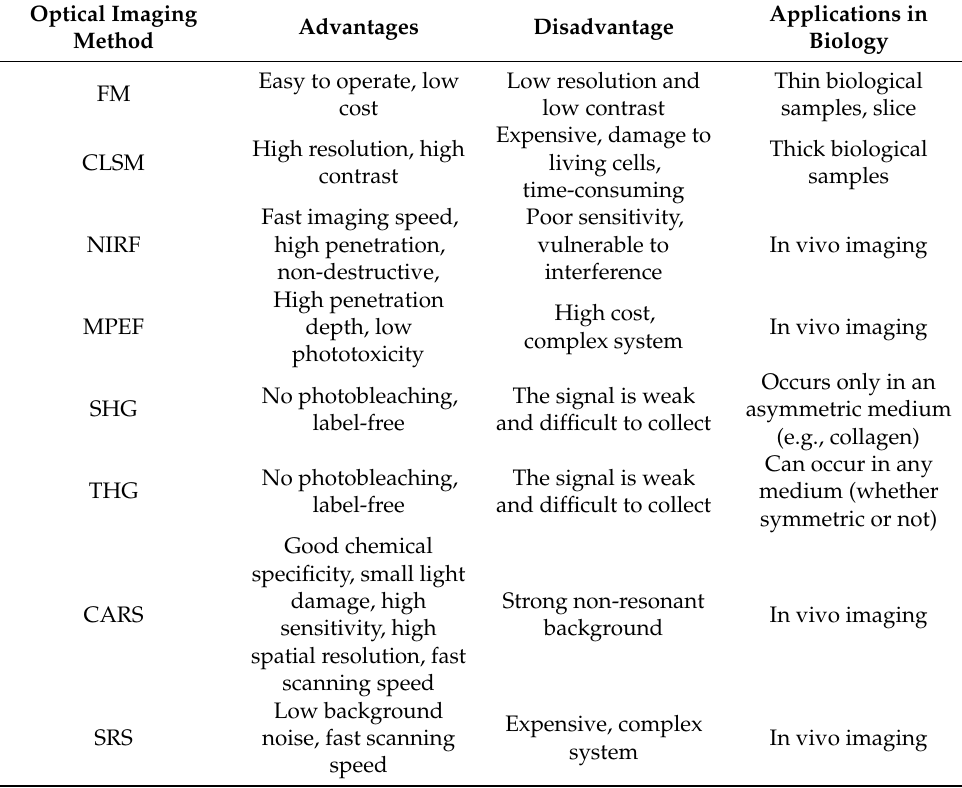
Table 2. Characteristics of optical imaging methods and their applications in biology. Optical